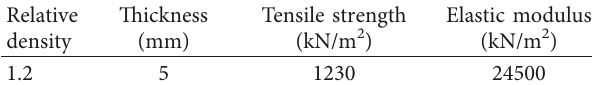
Table 1: Parameters of scrap tire strips.